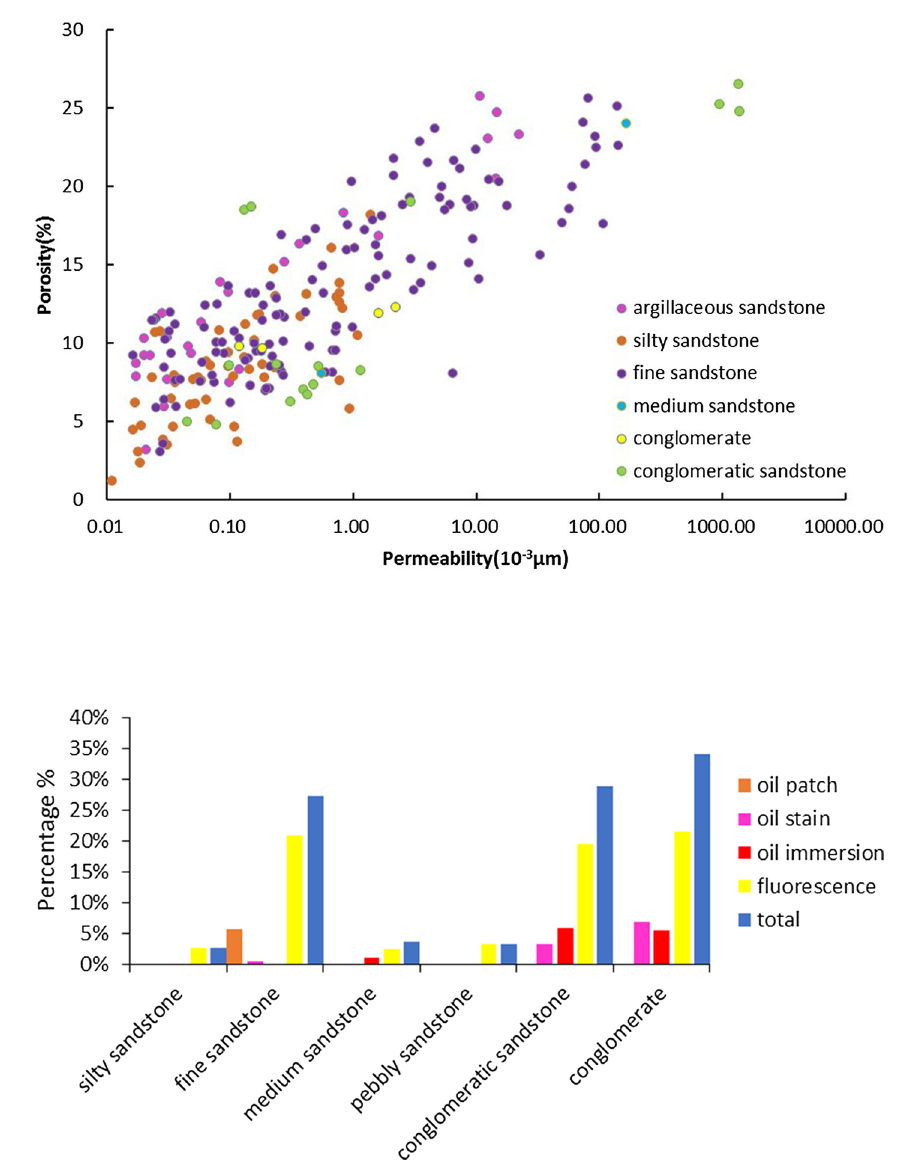
Fig. 4 Cross plot of porosity and permeability of sandstone reservoirs from the Oligocene Xiaganchaigou Formation (E 3 ) in the Lengdong area, Qaidam Basin, China. Sandstone reservoirs include argillaceous sandstone, silty sandstone, fine sandstone, medium sandstone, pebbly sandstone, conglomer- atic sandstone and conglomerate